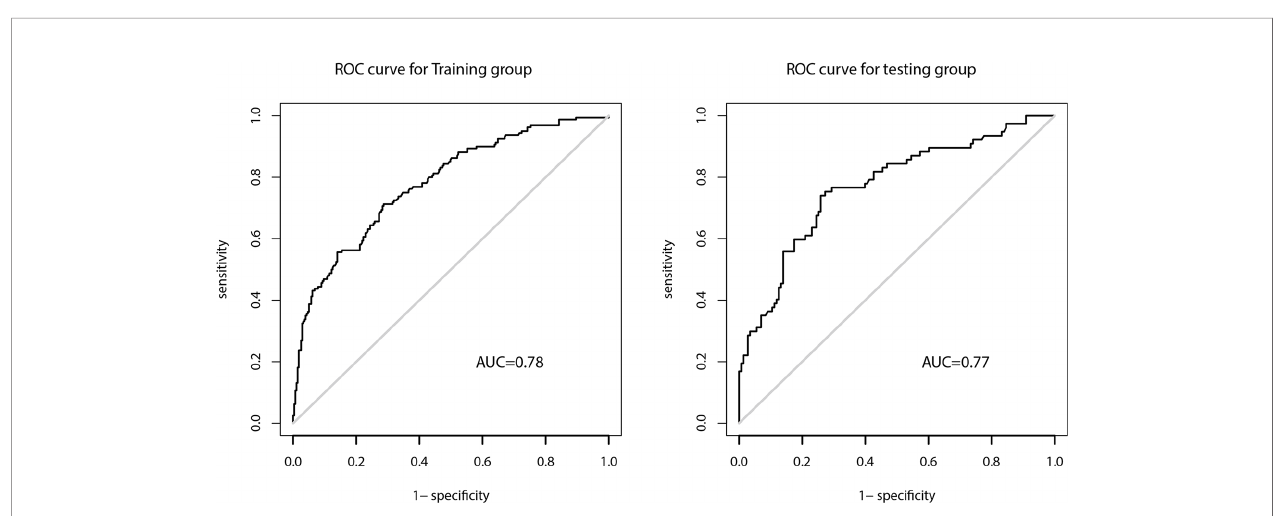
FIGURE 4 | The ROC of prediction model in the development and validation